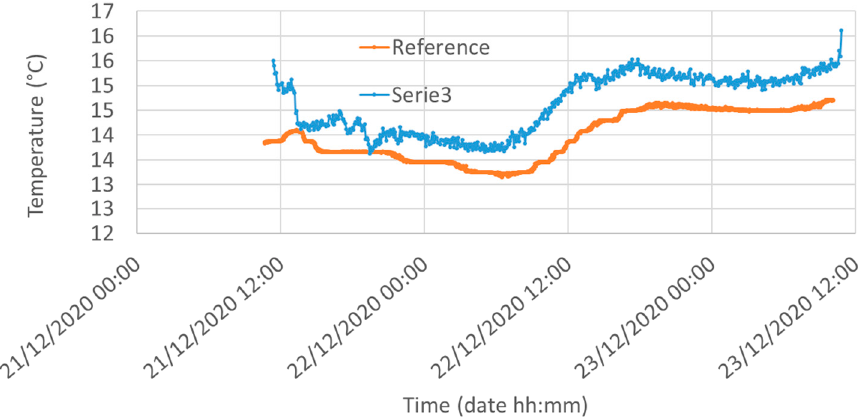
Figure 17. Temperature measured by the reference system (orange, 5 cm underground) and the LM35 mounted in Node #1 (blue) in Loamy Sand.